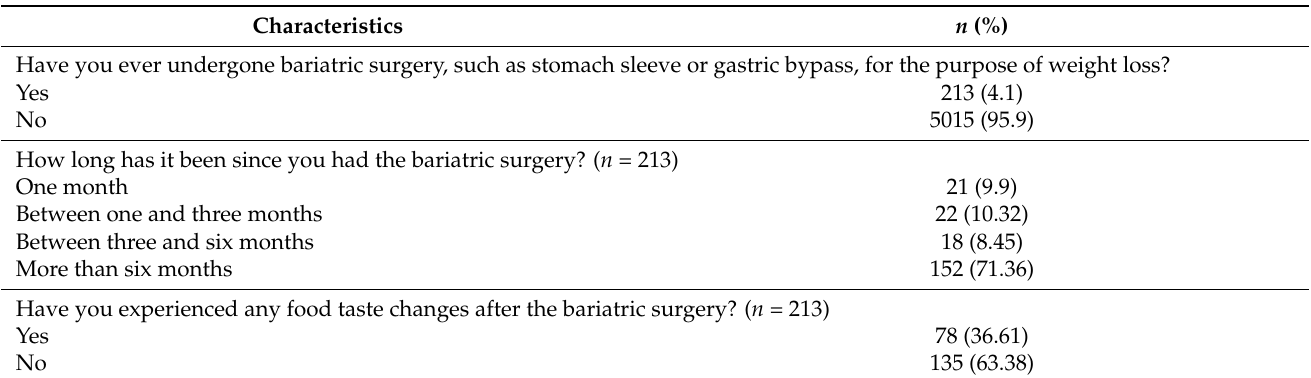
Table 2. Prevalence of bariatric surgeries and changes in food preference and